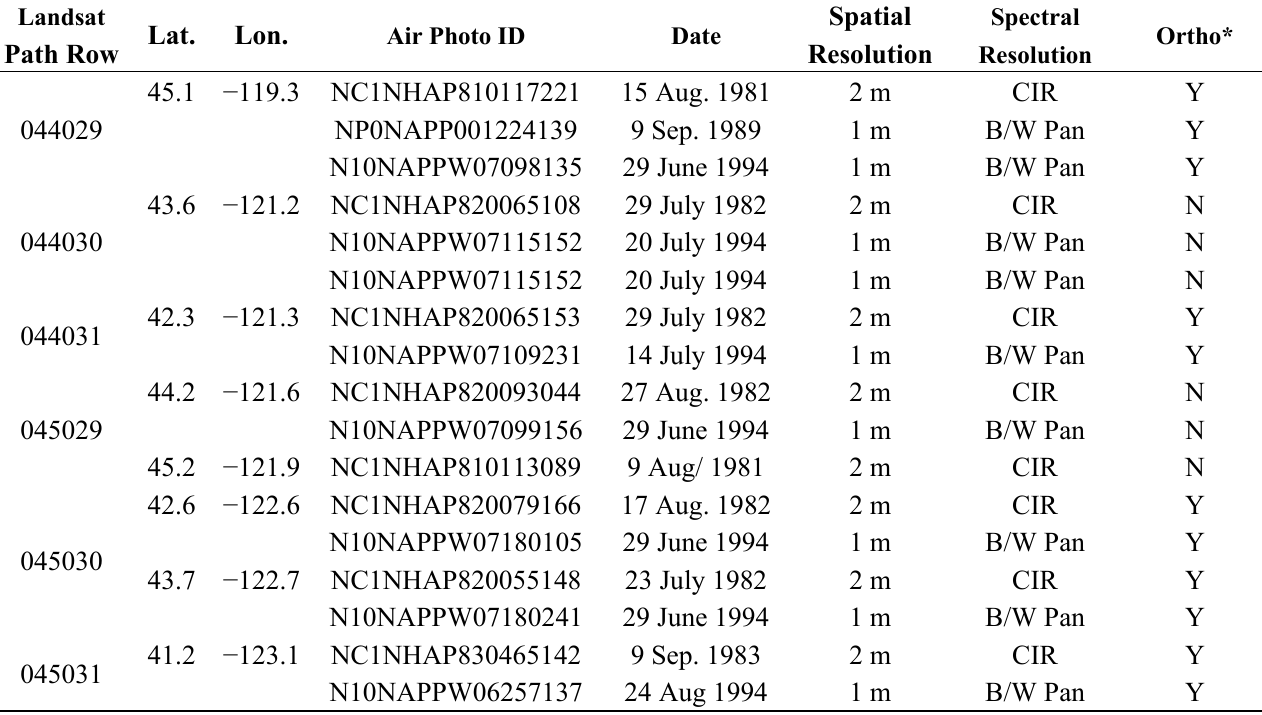
Table 2. Aerial photo evaluation